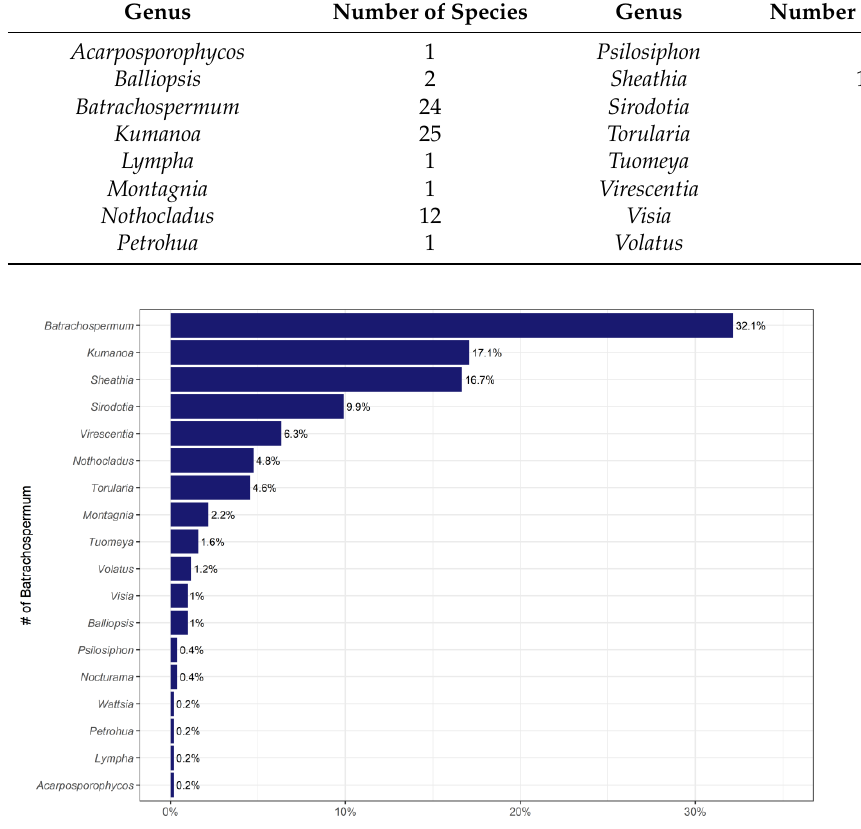
Figure 7. The proportion of sample data of each genus of Batrachospermaceae.